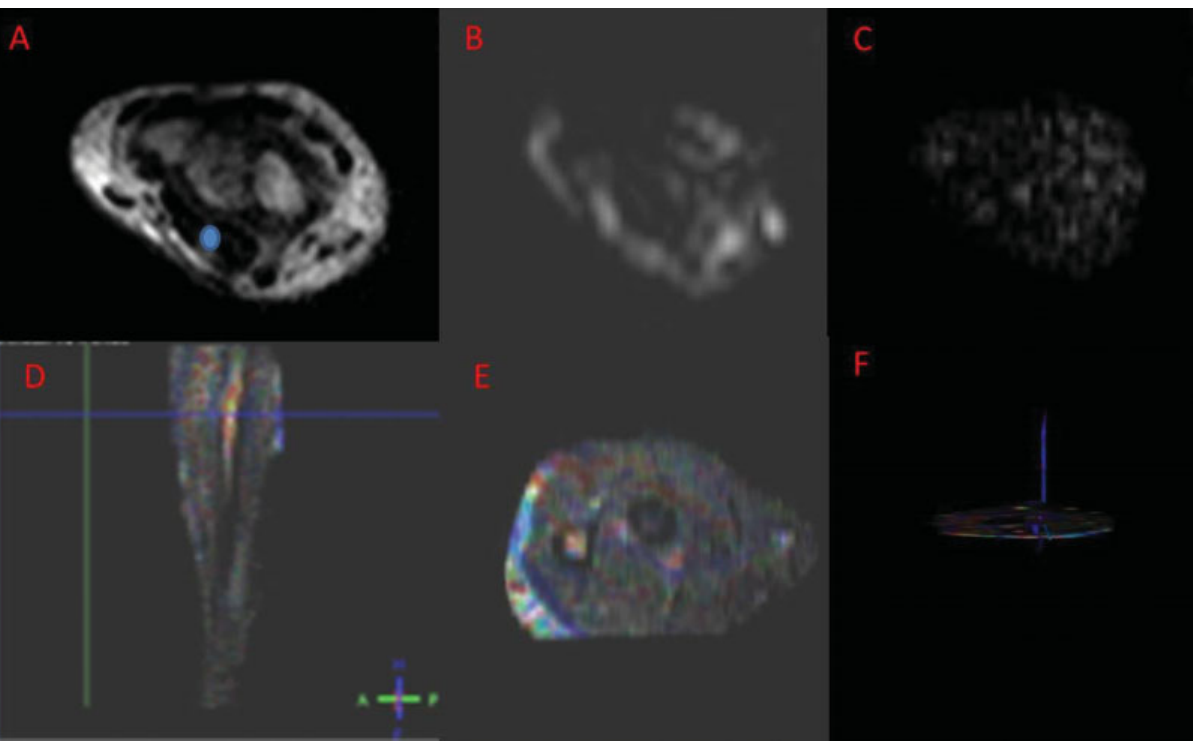
Fig.7 Right (peripheral nerve schwannoma) wrists of a 27-year-old female. T1-weighted magnetic resonance imaging (MRI; A ) at thelevel of the elbow shows the right median nerve (MN; region of interest). Corresponding ( B ) diffusion-weighted imaging and ( C ) diffusion tensor imaging maps. ( D ) Proximal level of the forearm . ( E ) ColorMap. ( F ) MN of the forearm. Tractography images show the MN in blue color